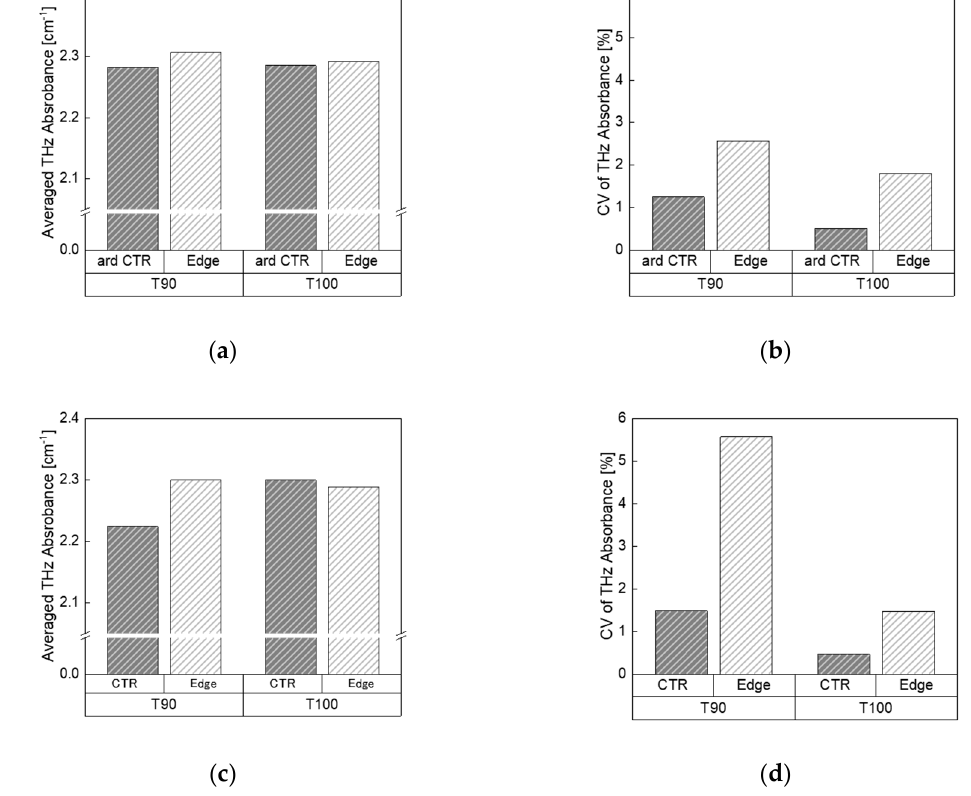
Figure 6. Comparison of the THz absorbance and the CV values of the THz absorbance in each section of T 90 and T 100 samples. ( a ) and ( c ) averaged THz absorbance in “around the center” and central part, and ( b ) and ( d ) CV of THz absorbance in “around the center” and central part, respectively.